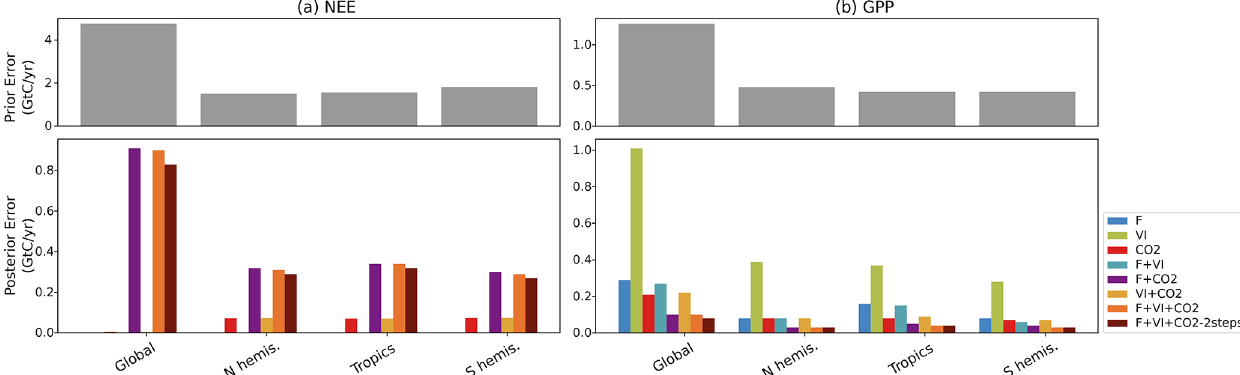
Figure 5. For NEE (a) and GPP (b) prior errors (top) and posterior errors obtained for each assimilation experiment (bottom), over the regions considered. For NEE, only the experiments involving atmospheric CO 2 data are shown.